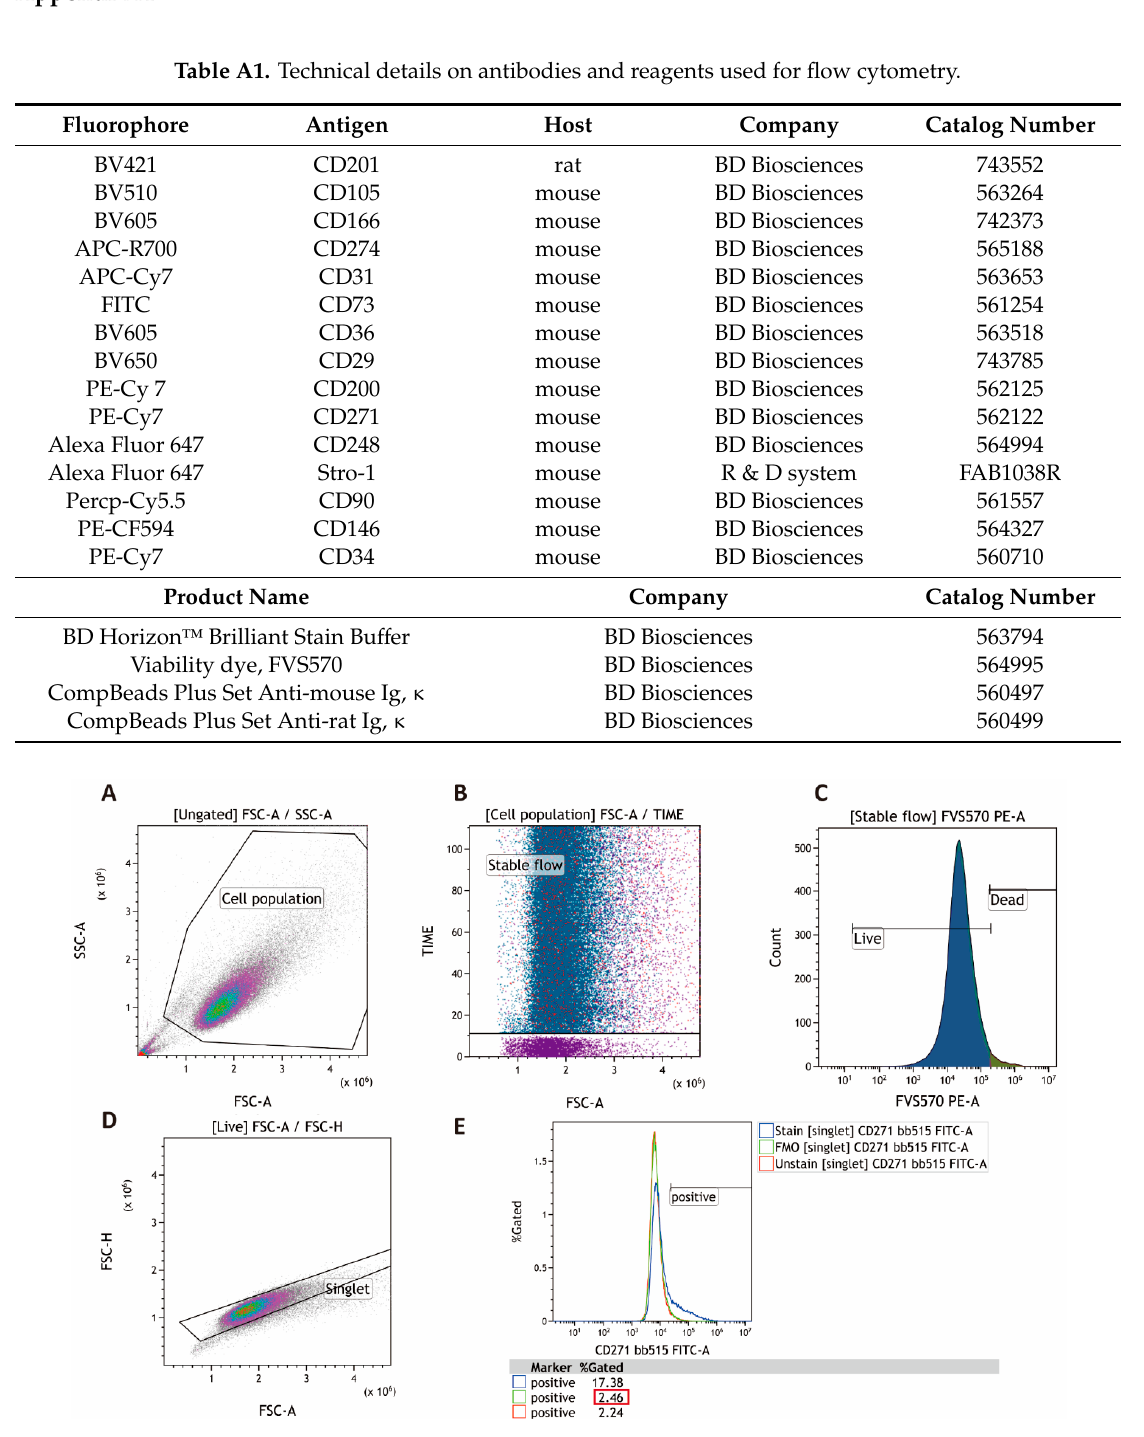
Figure A1. Gating strategy for flow cytometry. ( A ) Noise was removed to collect the cell population using forward scatter area (FSC-A) versus side scatter area (SSC-A). ( B ) To ensure a stable flow during data aquisition, the FSC-A versus time plot was controlled. ( C ) To exclude dead cells, viability dye (FVS570) was used. ( D ) The doublets were discriminated via FSC-A versus forward scatter height (FSC-H). ( E ) Representative of the overlay histogram of the unstained, fluorescence minus one (FMO) and stained group. Red box: the threshold was set at the 2.5% of FMO.